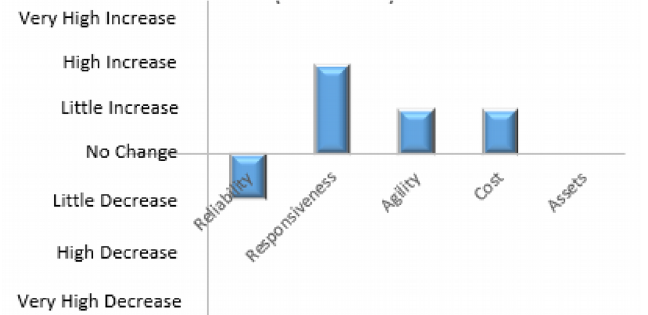
Figure 4. Performance measurement considerations by attribute during COVID-19